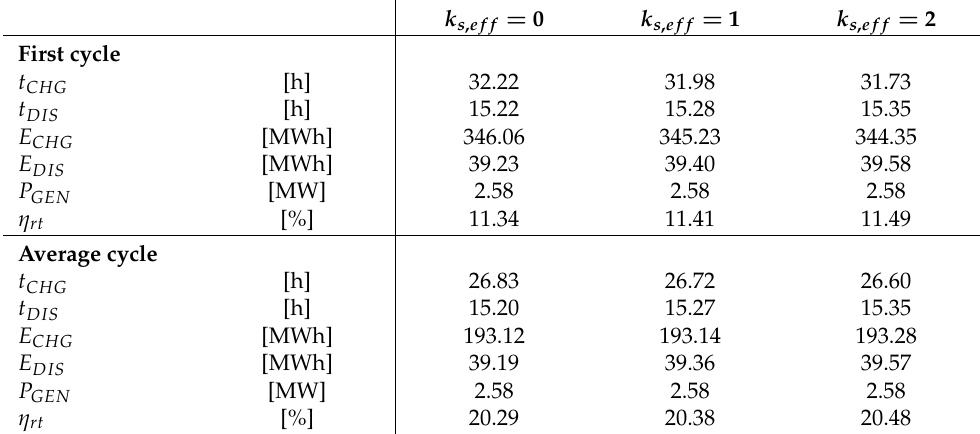
Table 4. Simulations for different choices of k s , ef f , adopting model TES-PD with variable